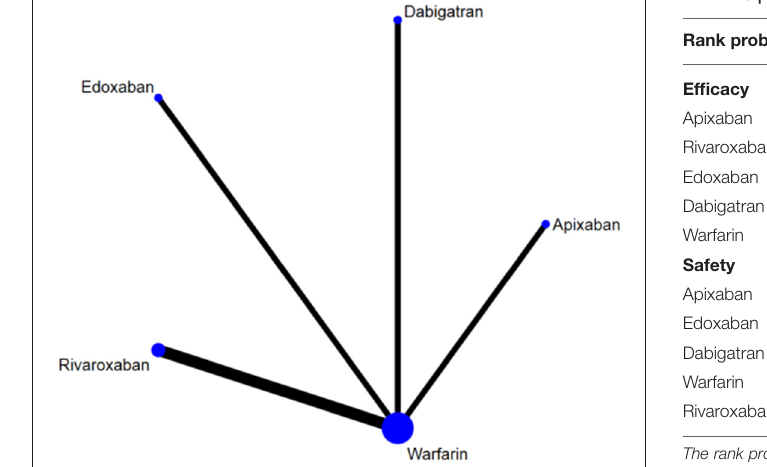
TABLE 3 | Rank probabilities of interventions on efficacy and